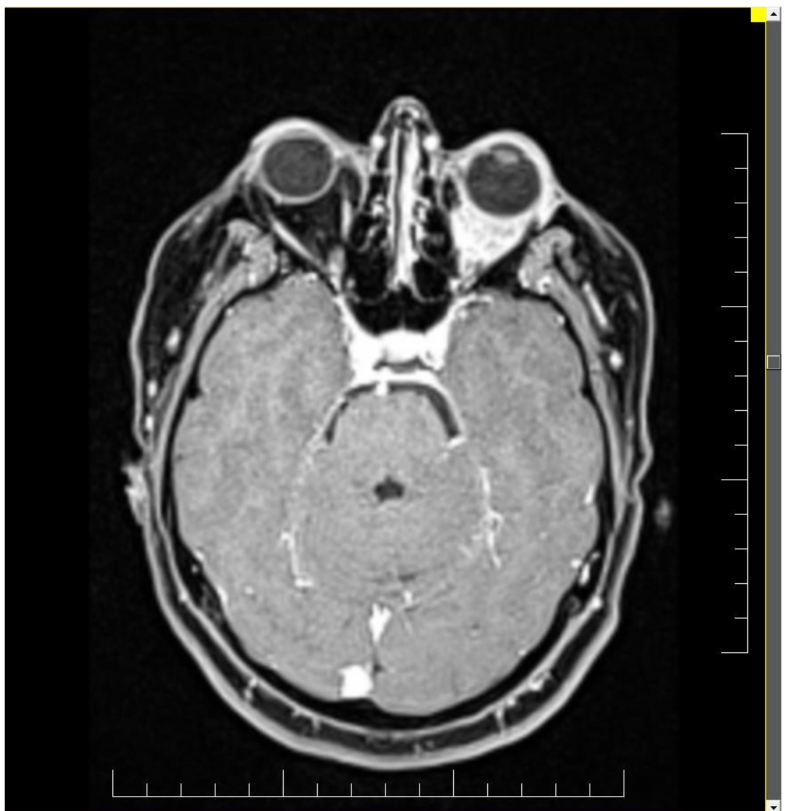
Figure 1. Brain CT scan showing an inhomogeneous mass with contrast agent capture in the retroocular space of the left orbit, cuffing the left optic nerve.